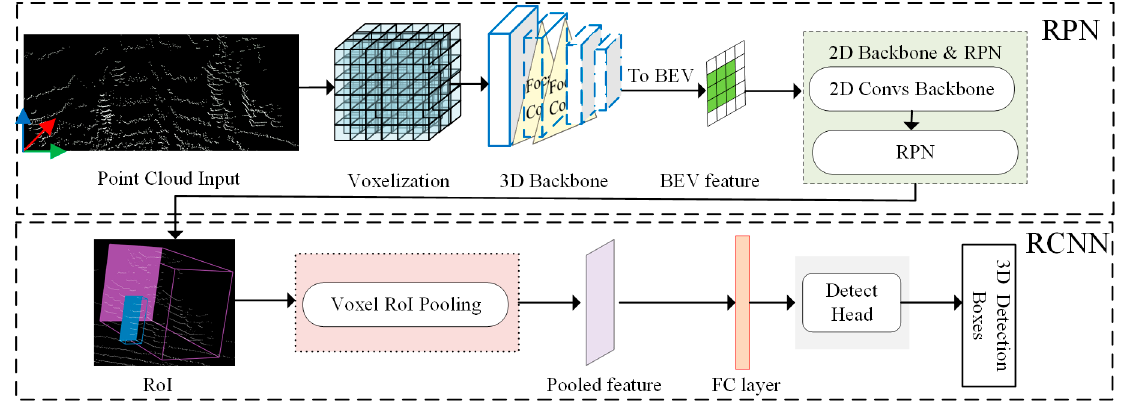
Figure 5. The structure of the Focal Voxel R-CNN. Algorithm 1 Focal Voxel R-CNN training